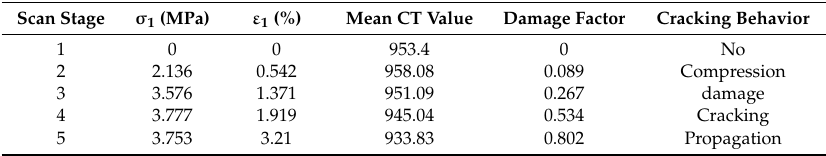
Table 3. Stress–strain mean CT value and damage characteristics of the CWRTB